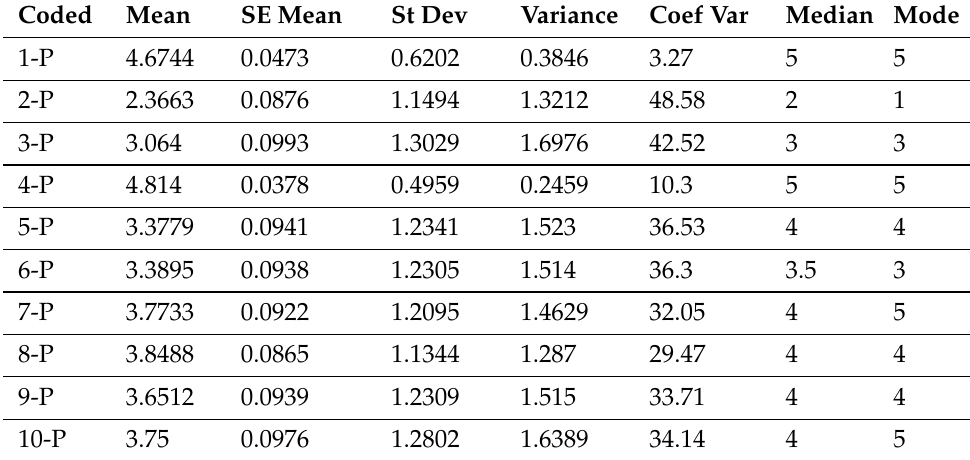
Table 3. Responses statistical